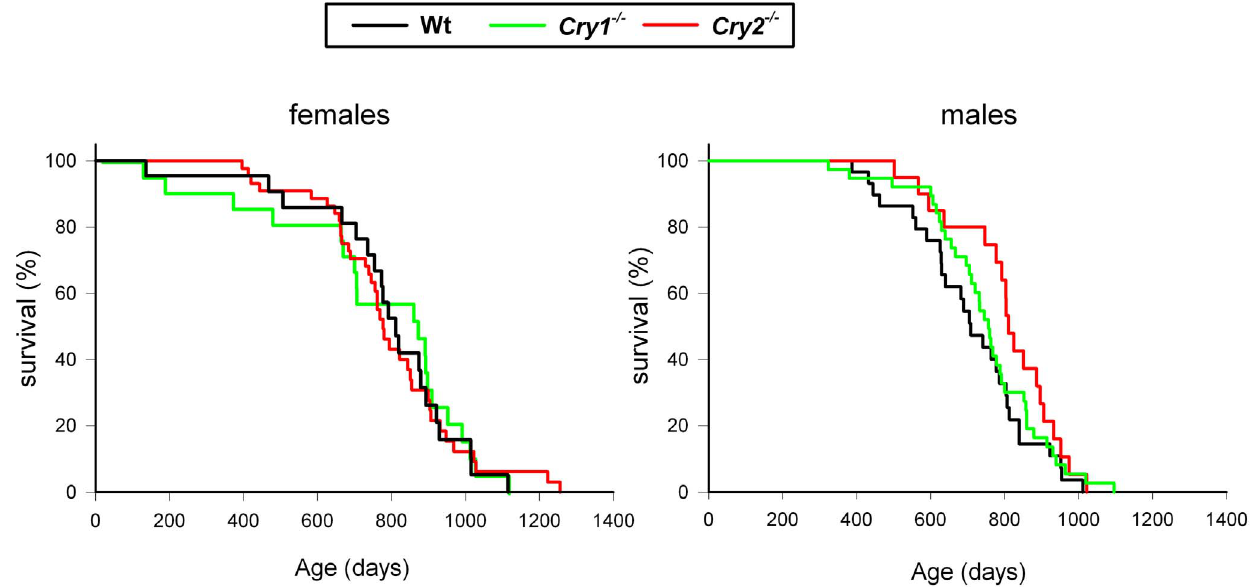
Figure 7. Life span of Cry1 -/- and Cry2 -/- mice. Age specific curves for female (left panel) and male (right panel) wild type, Cry1 -/- and Cry2 -/- mice. Animals were scored as dead from the cohort when found dead or when appearing moribund.